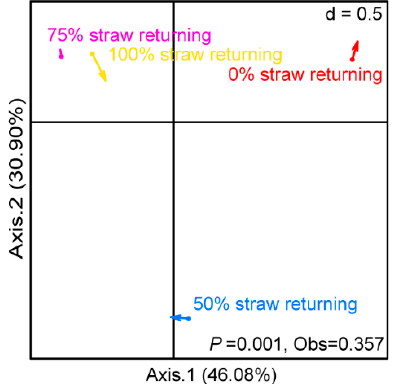
Figure 3. Co-inertia analysis (CIA) of bacteria and fungi when different amounts of straw were added. The direction of the arrow indicates the trend of the correlation between bacteria and fungi, while the length of the arrow indicates the strength of the correlation between bacteria and fungi. Each group had three replicates ( n = 3). After Monte Carlo test, p = 0.001.